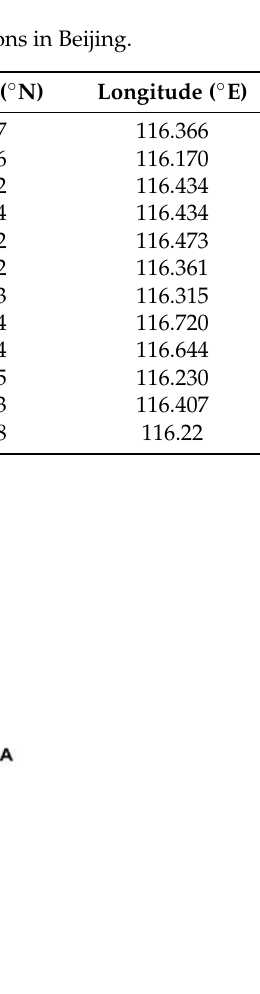
Figure 4. The air pollution spatial correlation weighted network of Beijing.